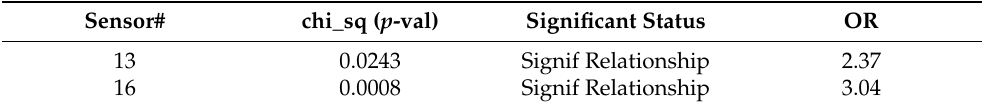
Table 6. Odds output from significant sensors.